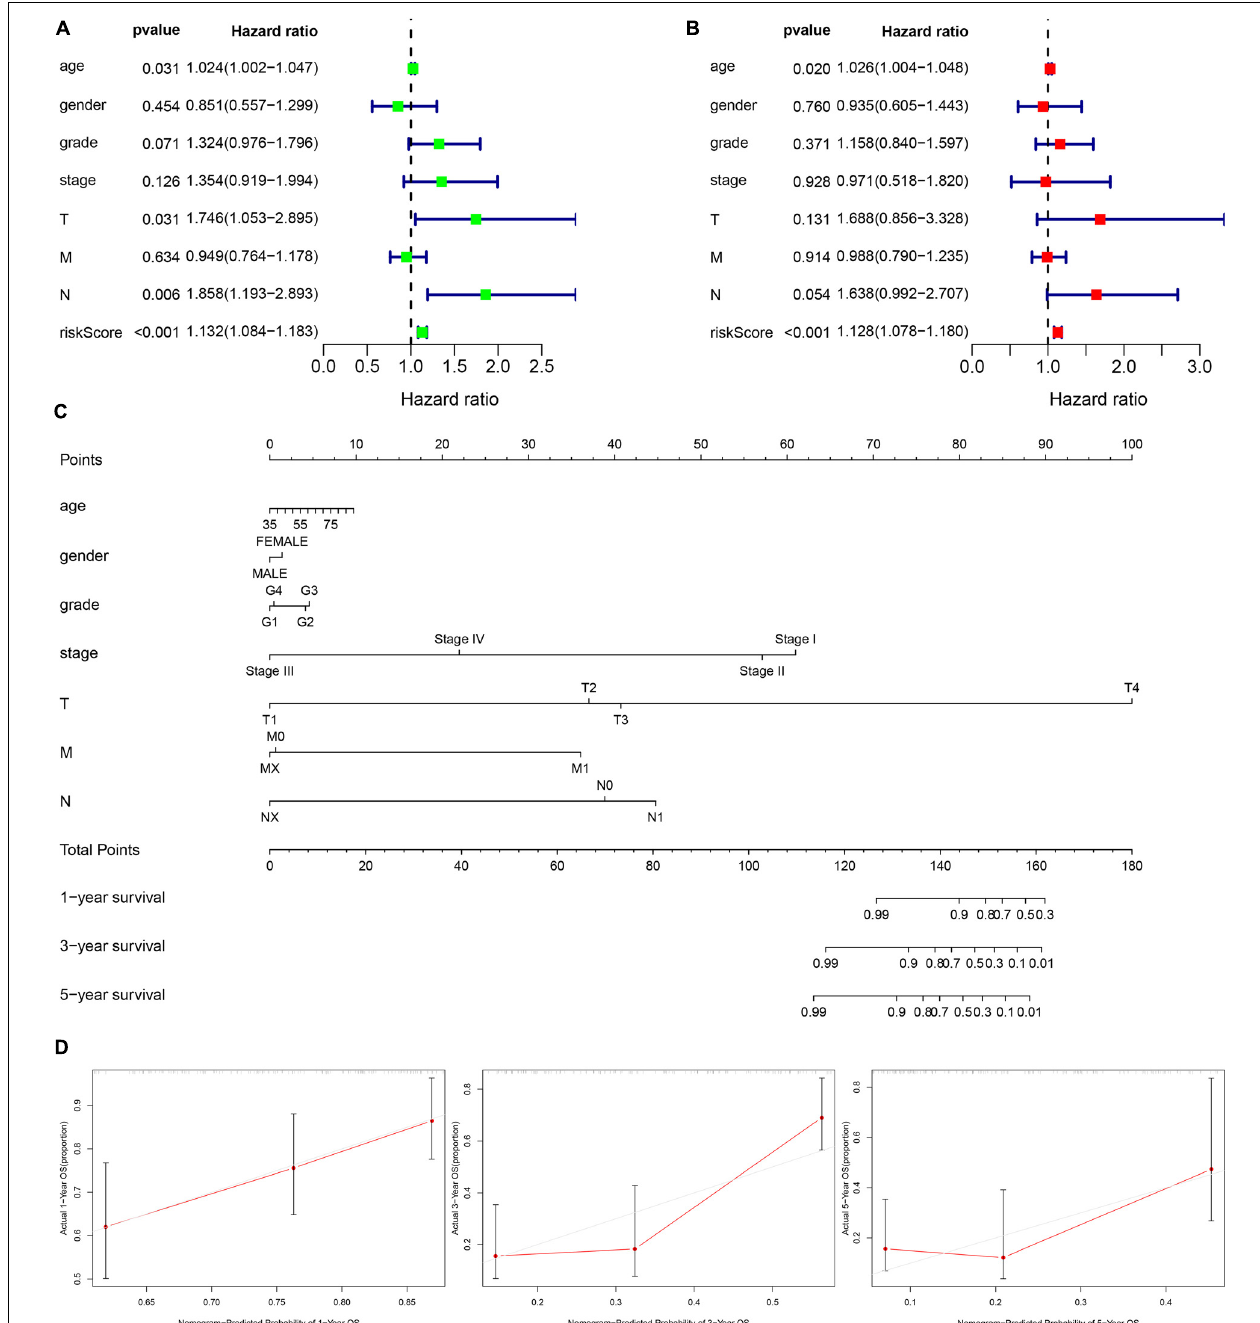
FIGURE 3 | Establishment of a nomogram based on clinical characteristics and the autophagy related lncRNAs signature. (A,B) Univariate Cox regression analysis (A) and Multivariate Cox regression analysis (B) of clinical features and the signature. (C) The nomogram consists of clinical characteristics and prognostic signature. (D) The nomogram calibration curve is used to predict 1, 3, and 5 years survival rates.